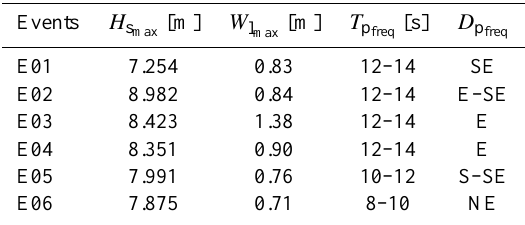
Table 3. Waves information for each events: H s significant wave height simulated at deep water, the W l higher water level at a Tramandaí coastal point and the T p the D p are the most frequently of the peak wave period and the freq peak wave direction in the computational